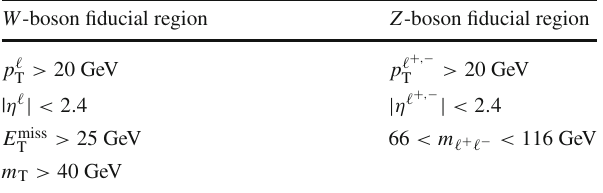
Table 2 Summary of the selection criteria that define the measured fiducial regions W -boson fiducial region Z -boson fiducial region